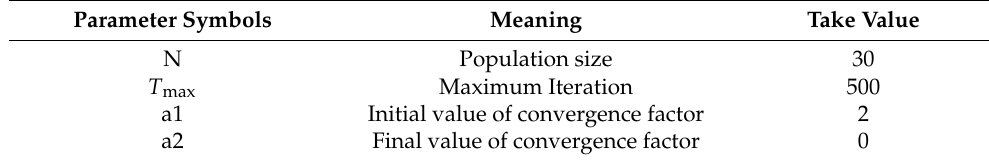
Table 1. Parameter Configuration.